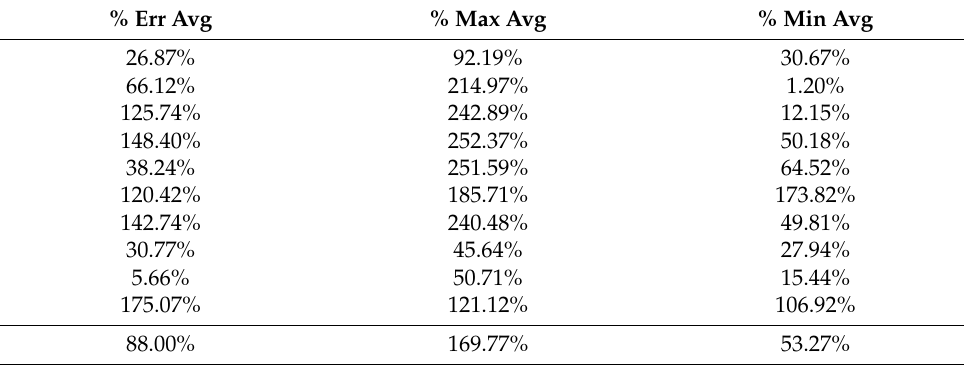
Table A104. Set 2, trials 11–20 data (actual PR